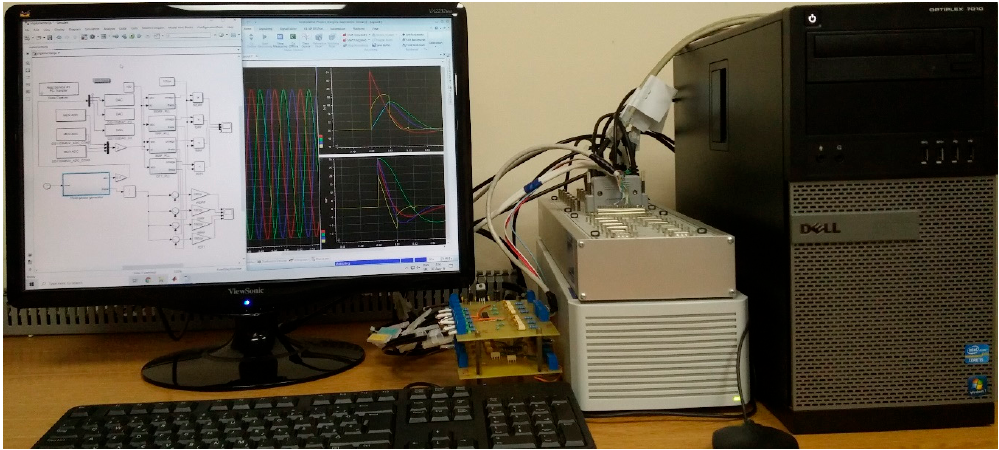
Figure 10. Photograph of the experimental setup.